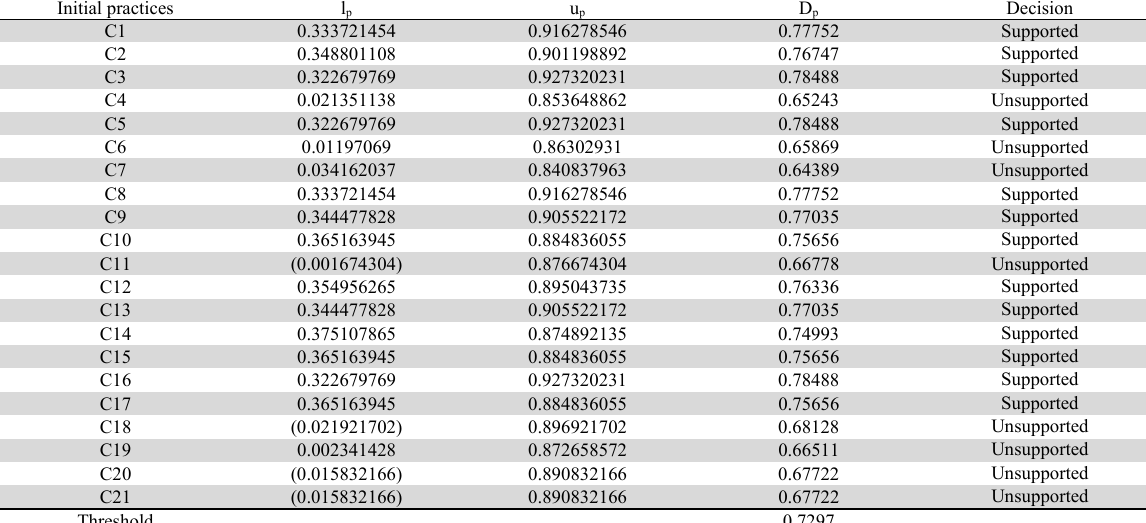
FDM screening out for enablers Initial practices